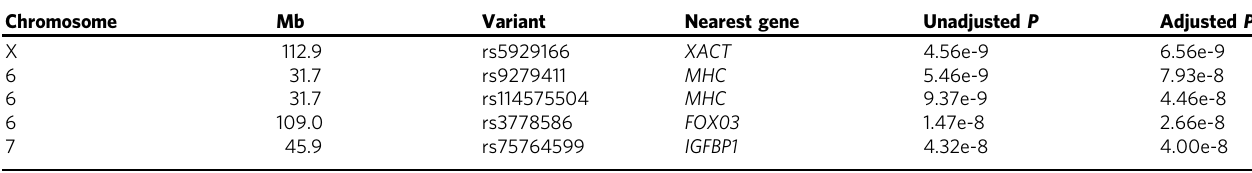
Table 5 P -values for four regions associated with Crohn ’ s disease prognosis